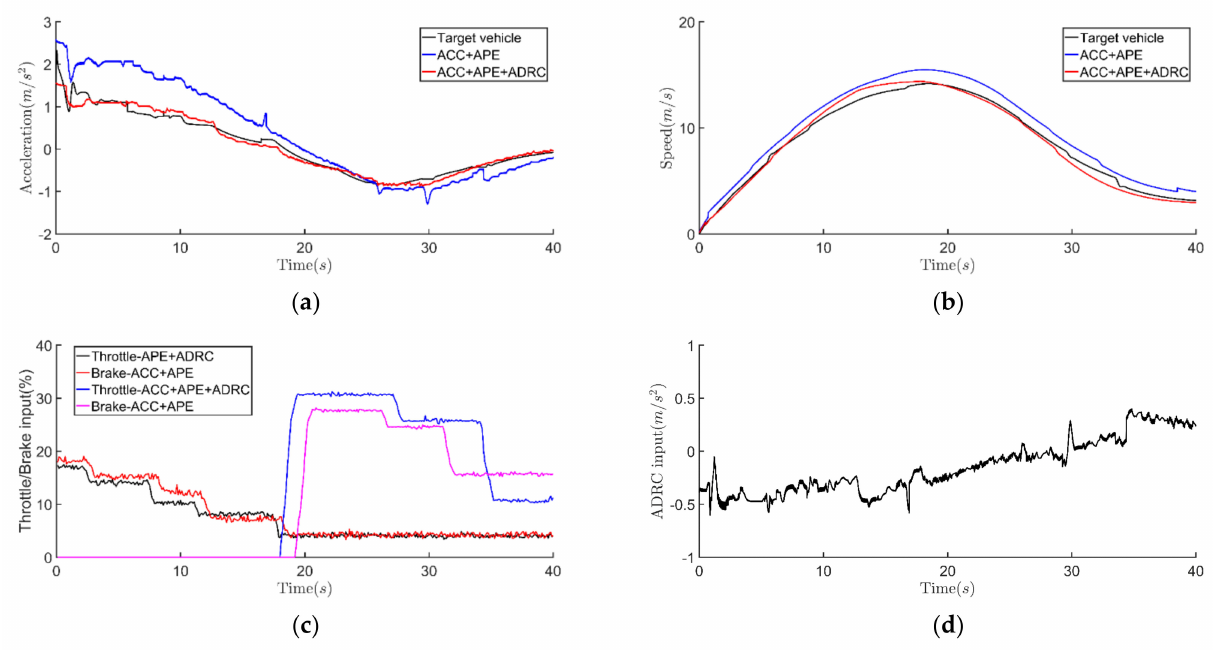
Figure 6. Comparison results for ACC − APE and ACC − APE − ADRC. ( a ) Acceleration; ( b ) speed; ( c ) throttle/brake input; and ( d ) ADRC